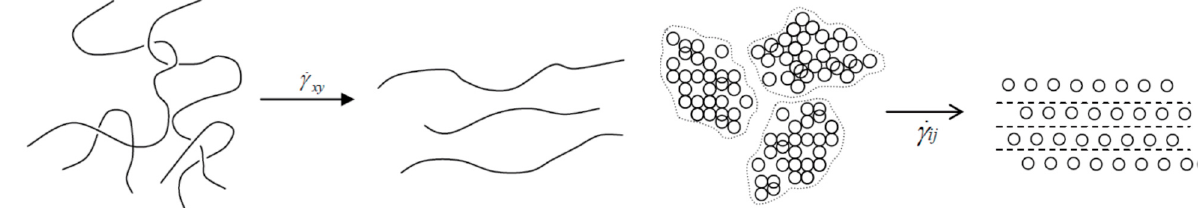
Figure 1. Shear-thinning mechanism in food systems. Disentanglement of long macromolecular chains ( Left ). Breakdown of loose particle clusters to form layered alignment ( Right ) (Reprinted from Tan et al., 2018 [16]. Permitted by Creative Commons Attribution-Non Commercial 4.0 International License http://creativecommons.org/licenses/by-nc/4.0/, accessed on 6 June 2022) [16].